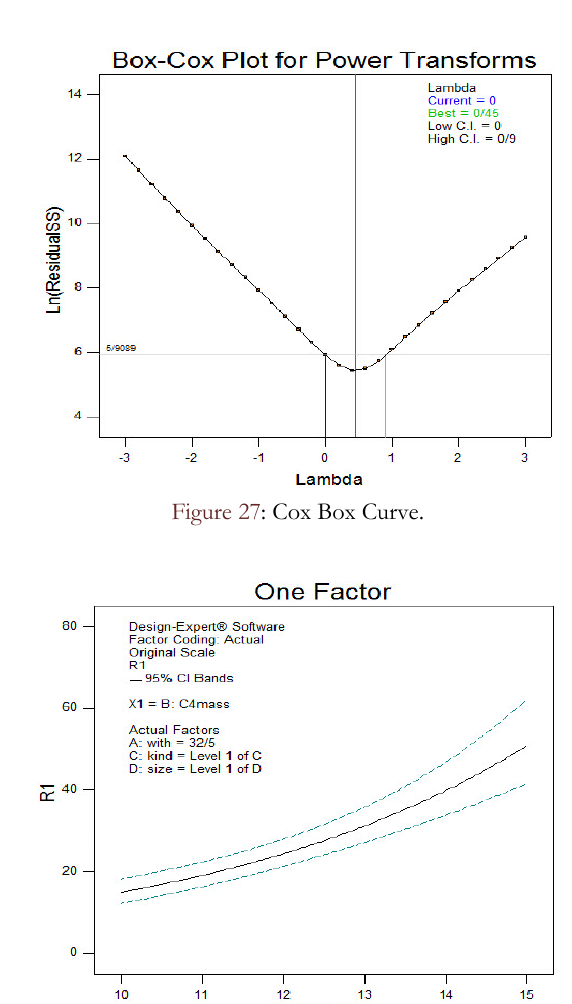
Figure 24: Real values versus predicted values. Figure 25: Normal residual diagram.